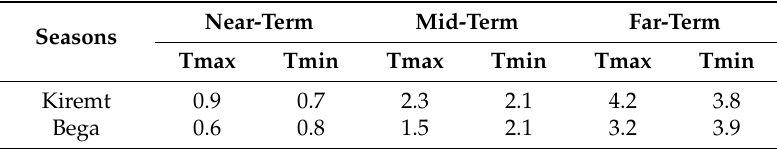
Figure 11. Seasonal variation of average temperature CFs (based on the three models) for the entire Awash basin (Tmax and Tmin maximum and minimum temperature, respectively).